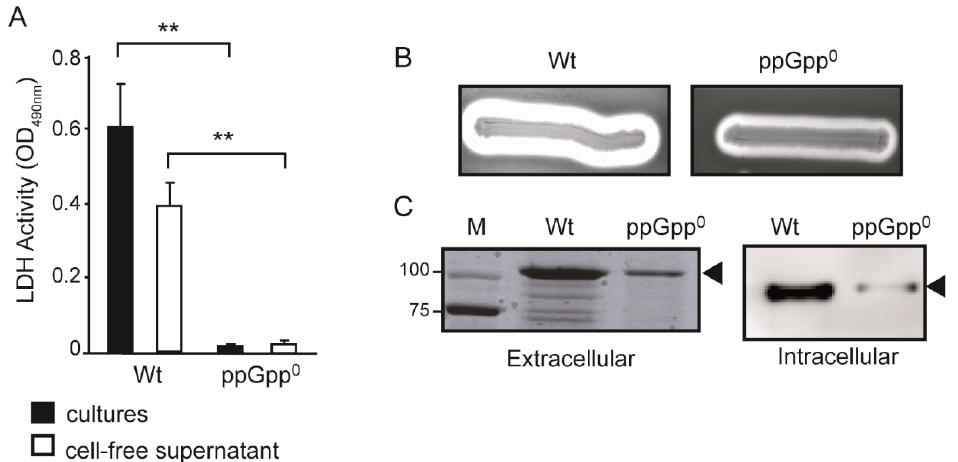
Figure 1. Effect of ppGpp on the expression of the hlyCABD II operon of J96. ( A ) Bacterial-induced cytotoxicity on T24 cells was monitored as lactate dehydrogenase (LDH) activity released (OD 490nm ) after 3 h incubation with bacterial cell suspensions (black bars) or cell-free supernatants (white bars). Bacterial cultures of the K-12 derivative AAG1 with plasmid pSF4000 (pACYC184 carrying hlyCABD II ) and its ppGpp 0 derivative (JFV2) were grown in LB at 37 °C up to late exponential phase (OD 600nm of 0.8). Data shown are mean and standard deviation of four independent determinations. Statistical significance levels are reported as ** = p < 0.005. ( B ) Hemolytic phenotype on blood agar plates of the AAG1 (Wt) and JFV2 (ppGpp 0 ) carrying the plasmid pSF4000. ( C ) Amount of α -hemolysin produced in bacterial cultures of the same strains as in panel ( B ), grown in LB at 37 °C up to an OD 600nm of 0.8. Left panel, secreted α -hemolysin (extracellular) was detected in cell-free supernatant from the cultures by Coomassie blue stained 10% SDS-PAGE. Lane M: molecular mass markers (size in kDa indicated along the left side). Right panel, intracellular α -hemolysin was determined by immunoblot analysis. The band corresponding to the α -hemolysin is indicated by an arrowhead.